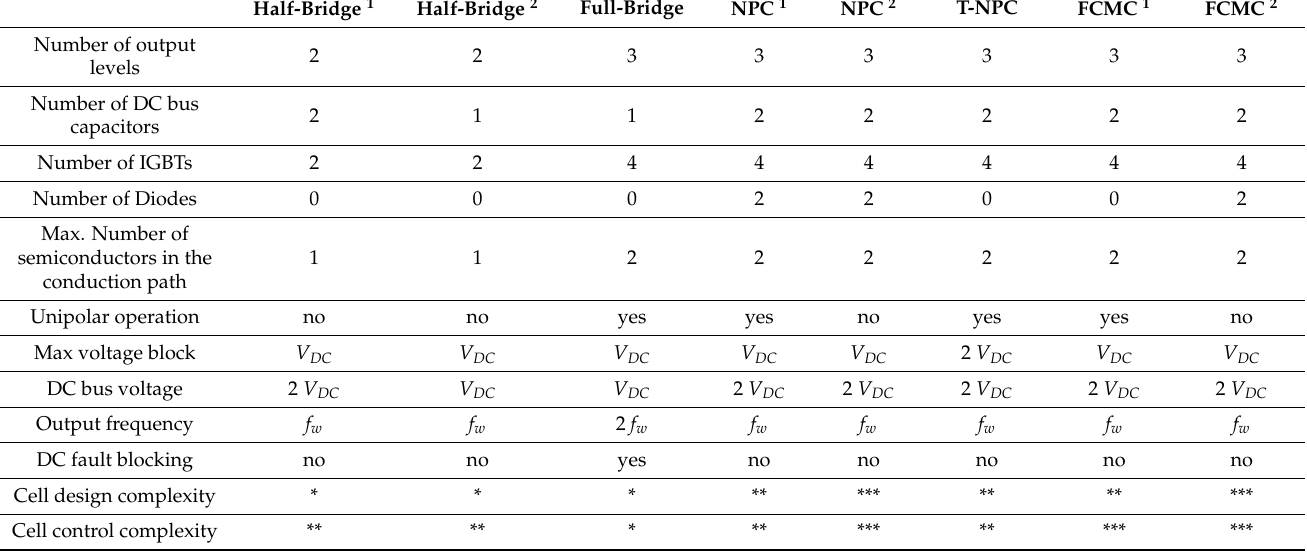
Table 1. Comparative table of submodule